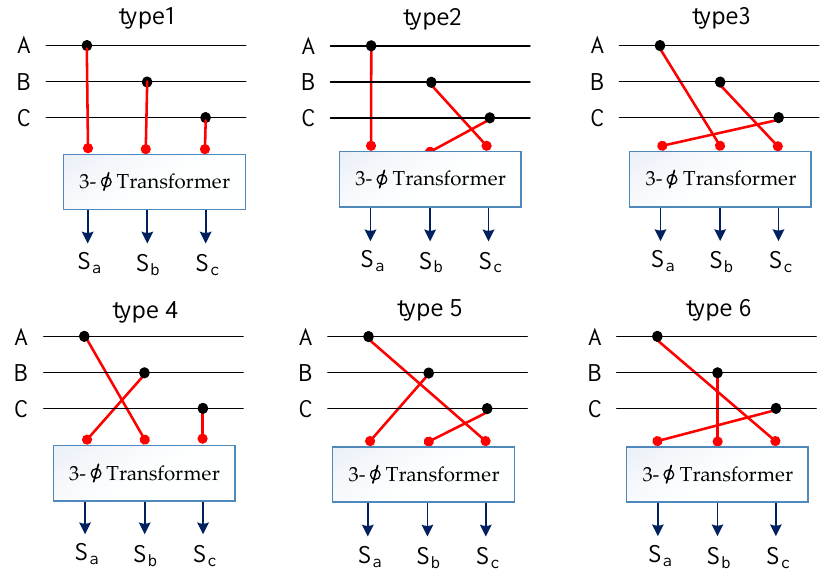
Figure 7. Various connections between the individual distribution transformer and the lateral and tapped-off points in the feeder main.